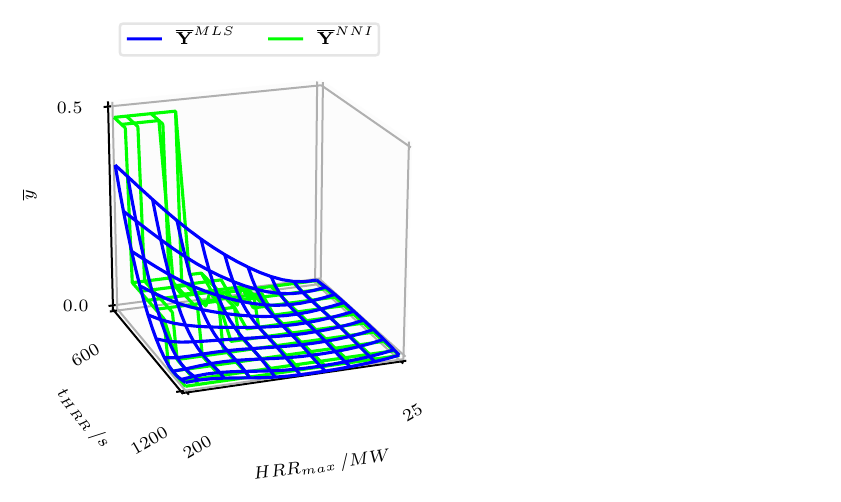
Figure 4. RSMs subjected to MLS and NNI for points with t pre = 147s and N tu = 39 for TA.